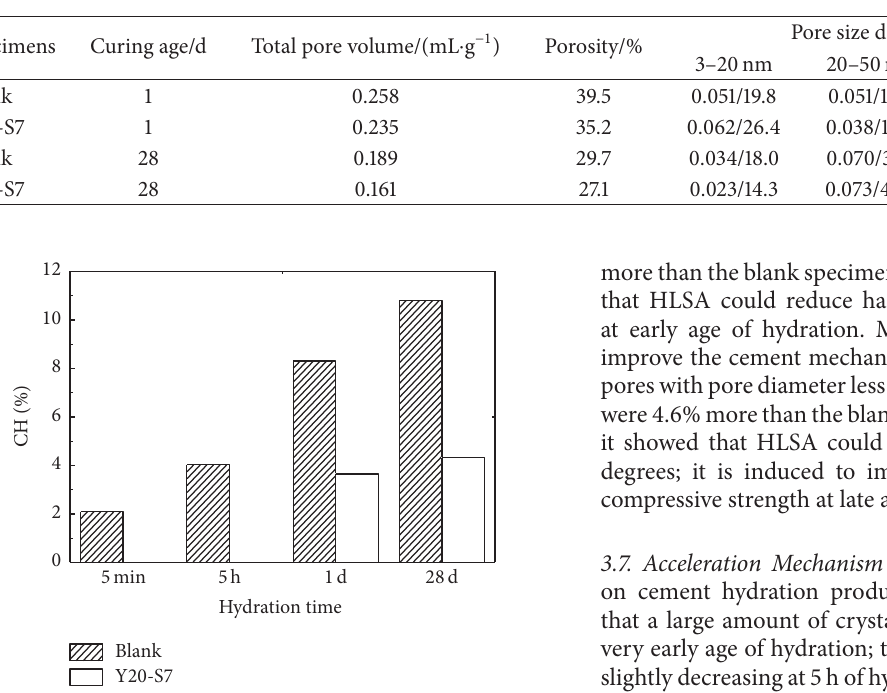
Table 6: Parameters and distribution of pore of cement pastes at 1d and 28 d.